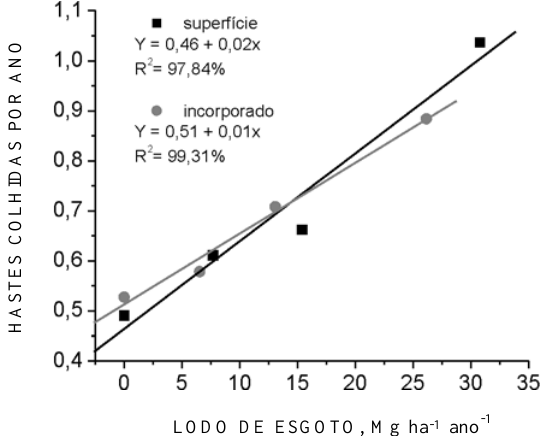
Figura 1. Número médio de hastes colhidas por ano de acordo com as doses de lodo de esgoto aplicadas anualmente, em superfície ou incorporadas, durante a fase de manutenção da cultura da pupunheira.